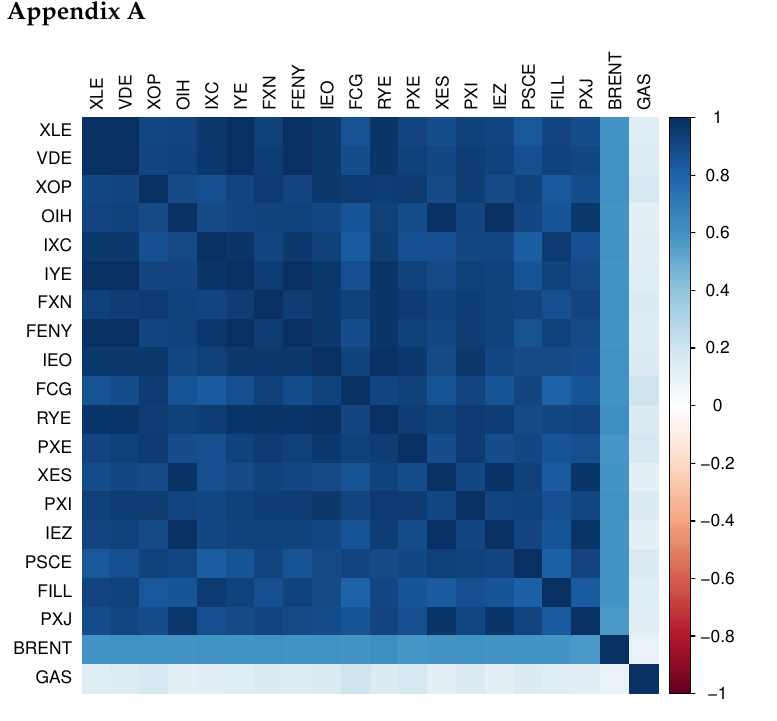
Figure A1. Pearson correlation for returns of oil, gas, and